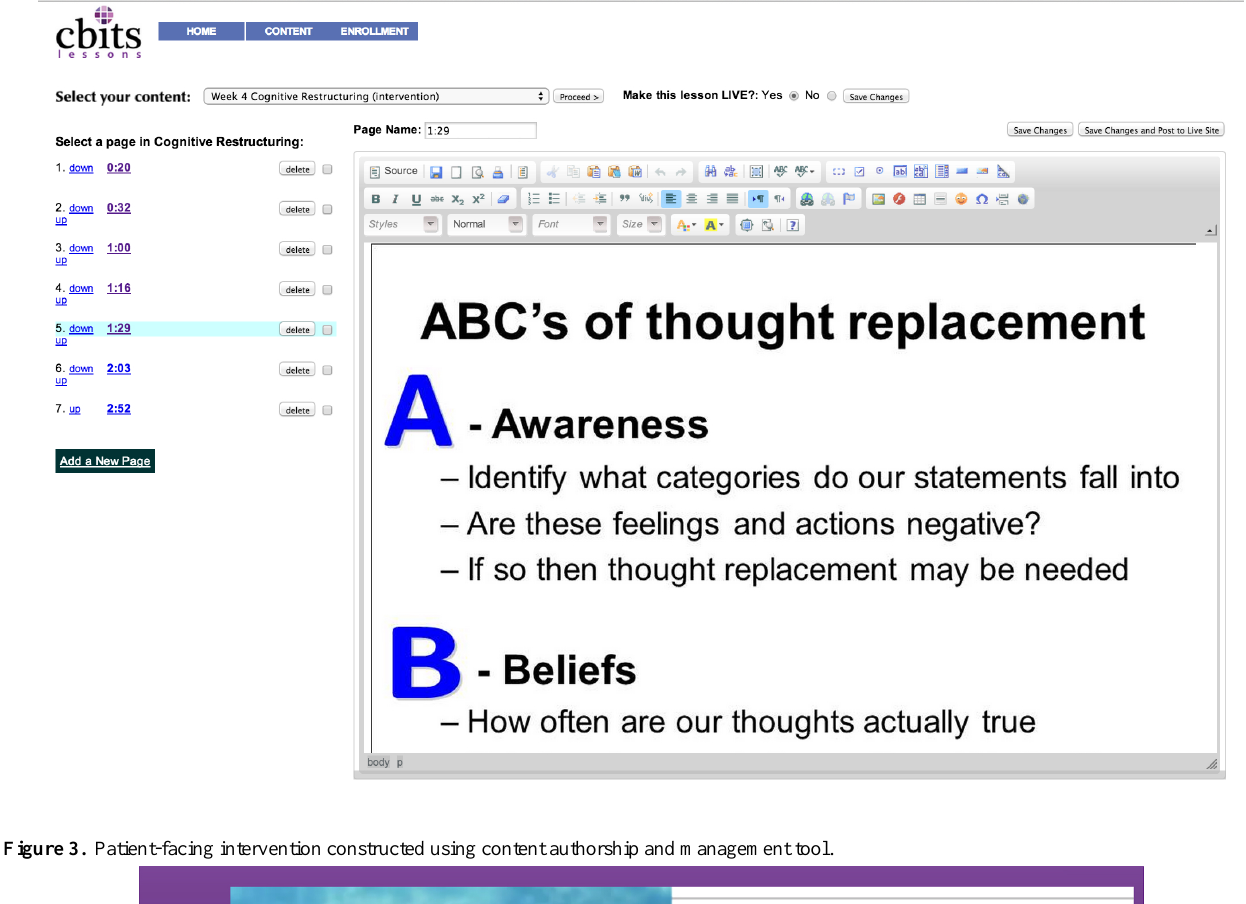
Figure 2. Purple “editor” content authorship and management tool.